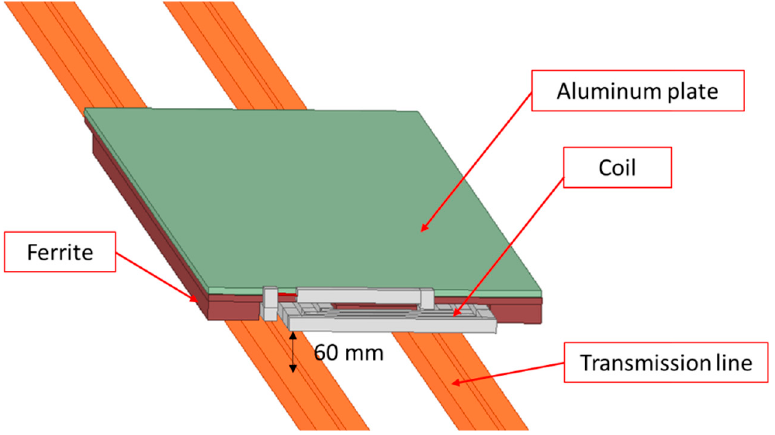
Figure 4. Structure of the power line and pick-up for EMF simulation.